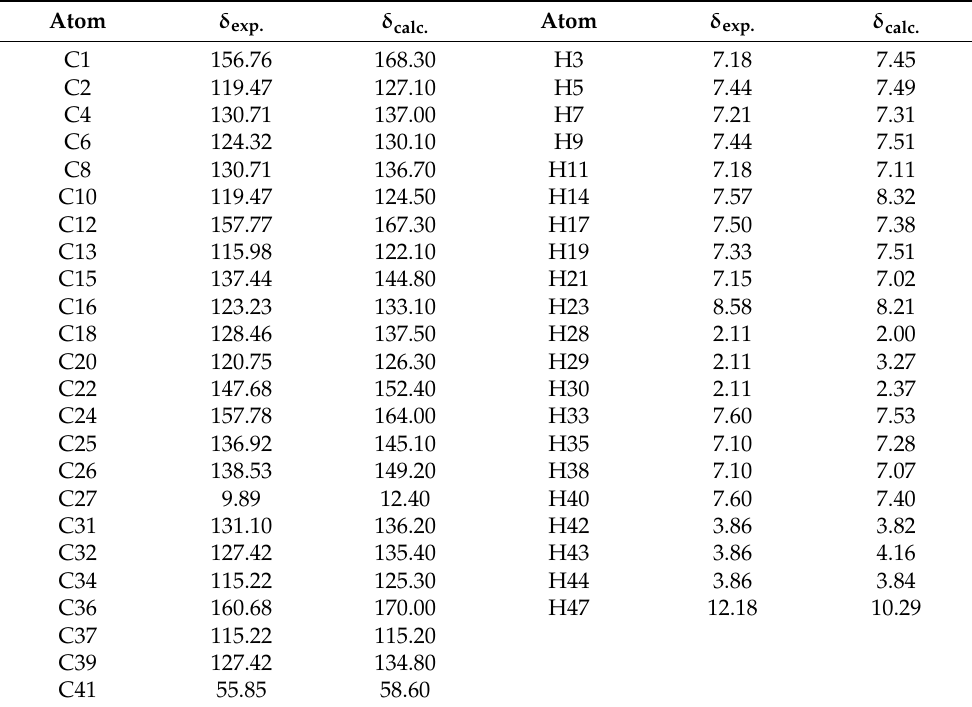
Table 3. The experimental and computed 1 H and 13 C NMR isotropic chemical shifts of 2 in DMSO- d 6 (related to the TMS as a standard; ppm). Atom δ